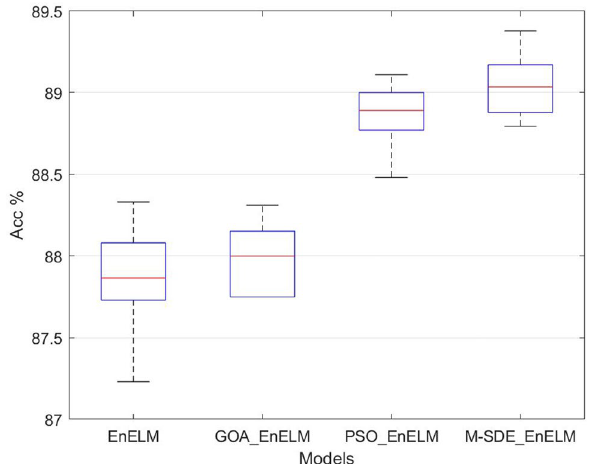
Figure 9. Ensemble classifier experiments.